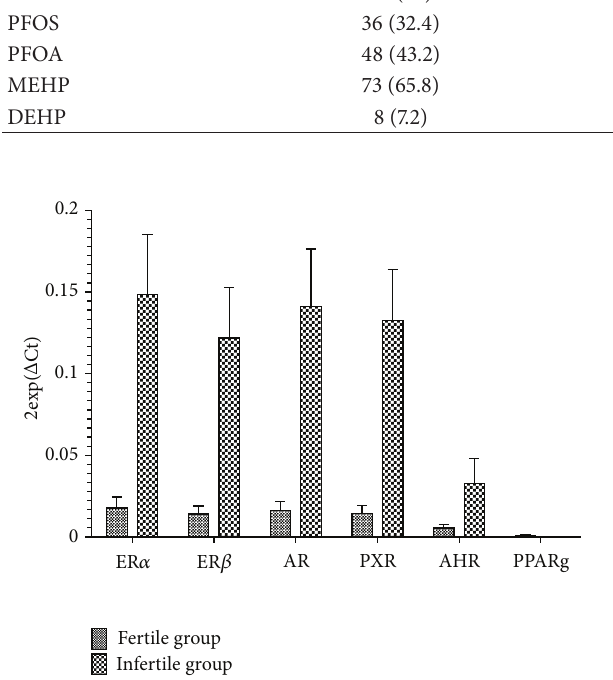
Figure 1: Nuclear receptors expression in infertile and fertile women.